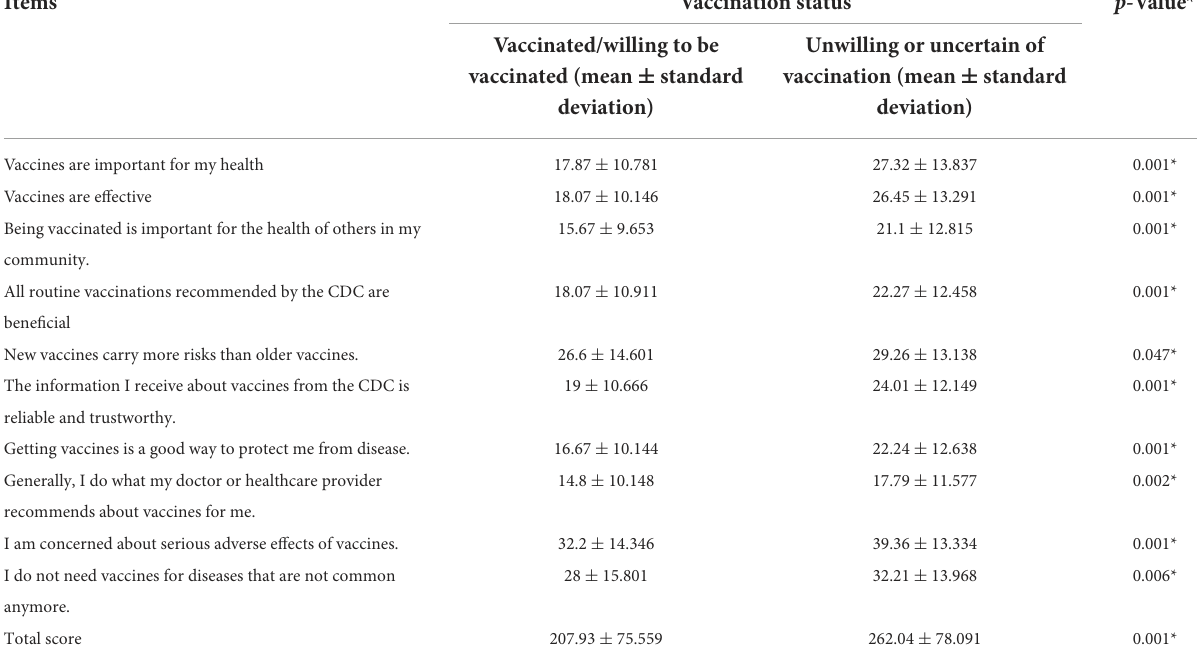
TABLE 2 Vaccine hesitancy scale